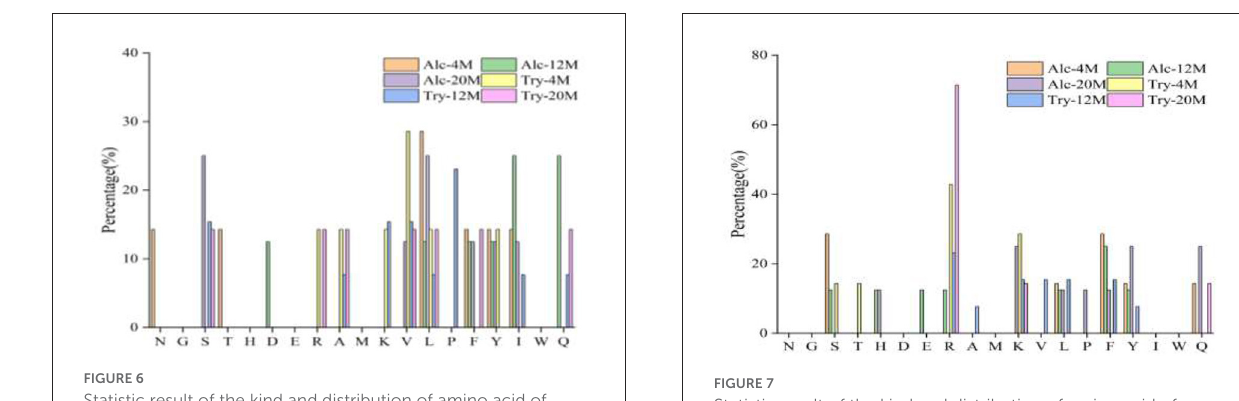
FIGURE7 Statistic result of the kind and distribution of amino acid of N-terminal in the peptides.